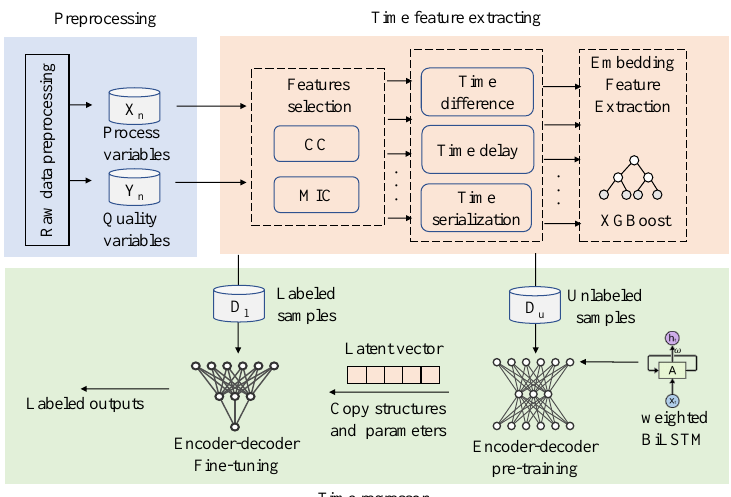
Figure 8. Brief flowchart of semi-supervised dynamic time features expanding and extraction prediction framework